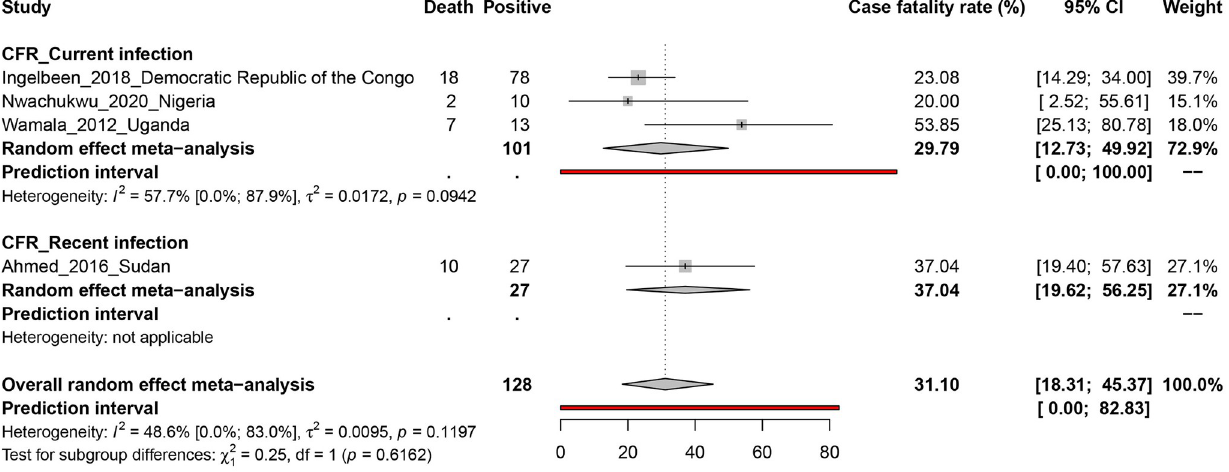
Fig 3. Case fatality rate estimate of yellow fever virus infections in humans in sub-Saharan Africa.